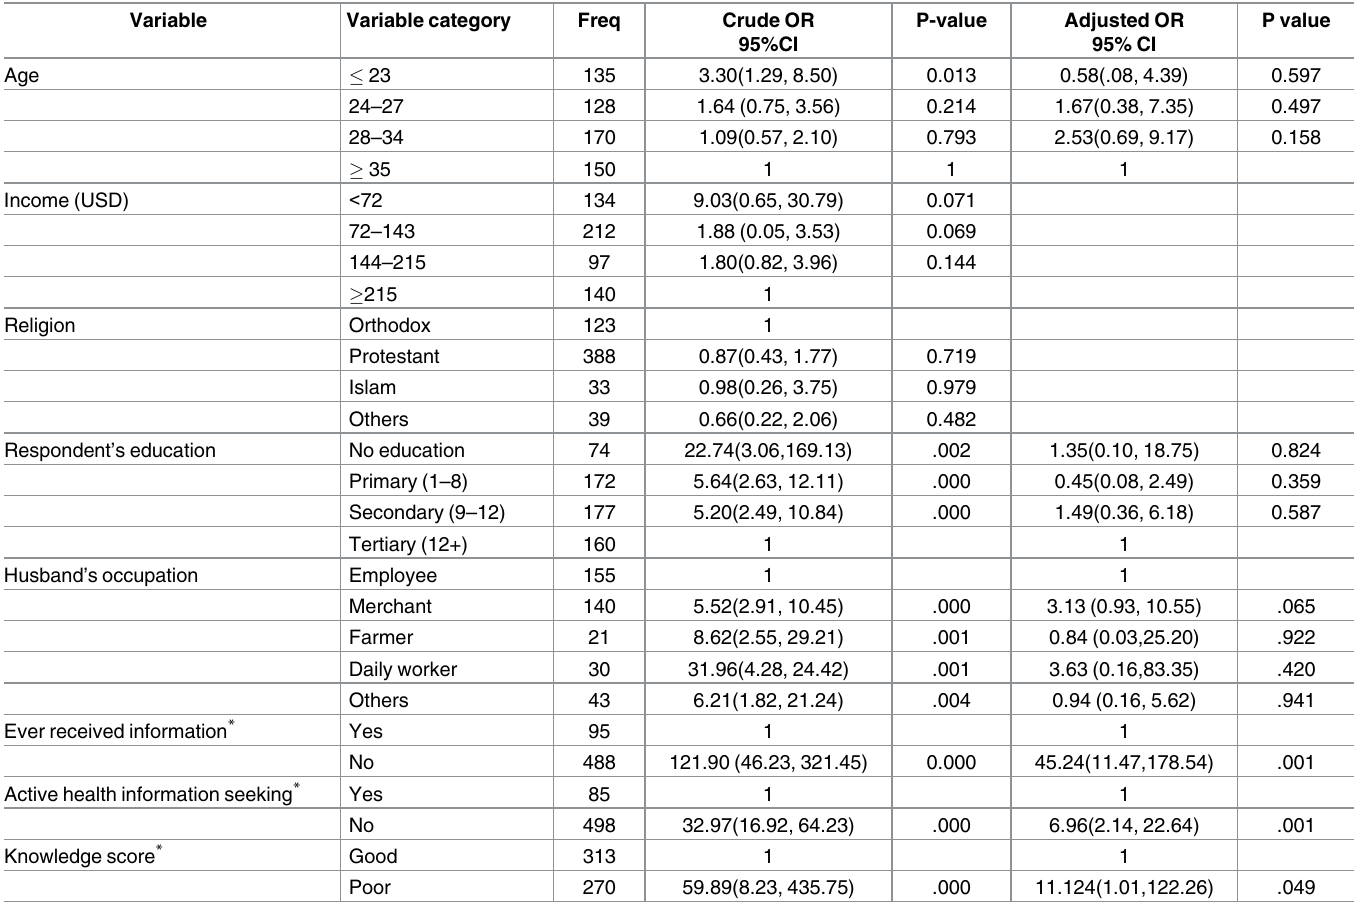
Table 5. Factors tested for association with screening practicesfor cervicalcancer among the respondents in Hossana town Hadiya Zone, June, 2015.